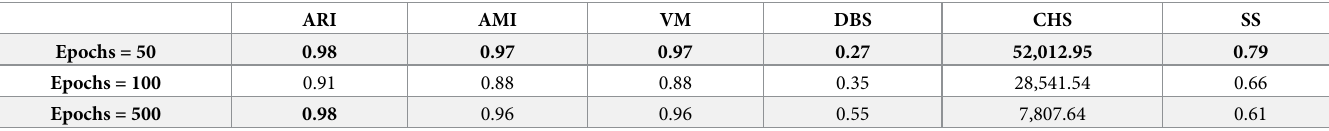
perspective of the clustering (first three metrics), while it actually decreases the performance of